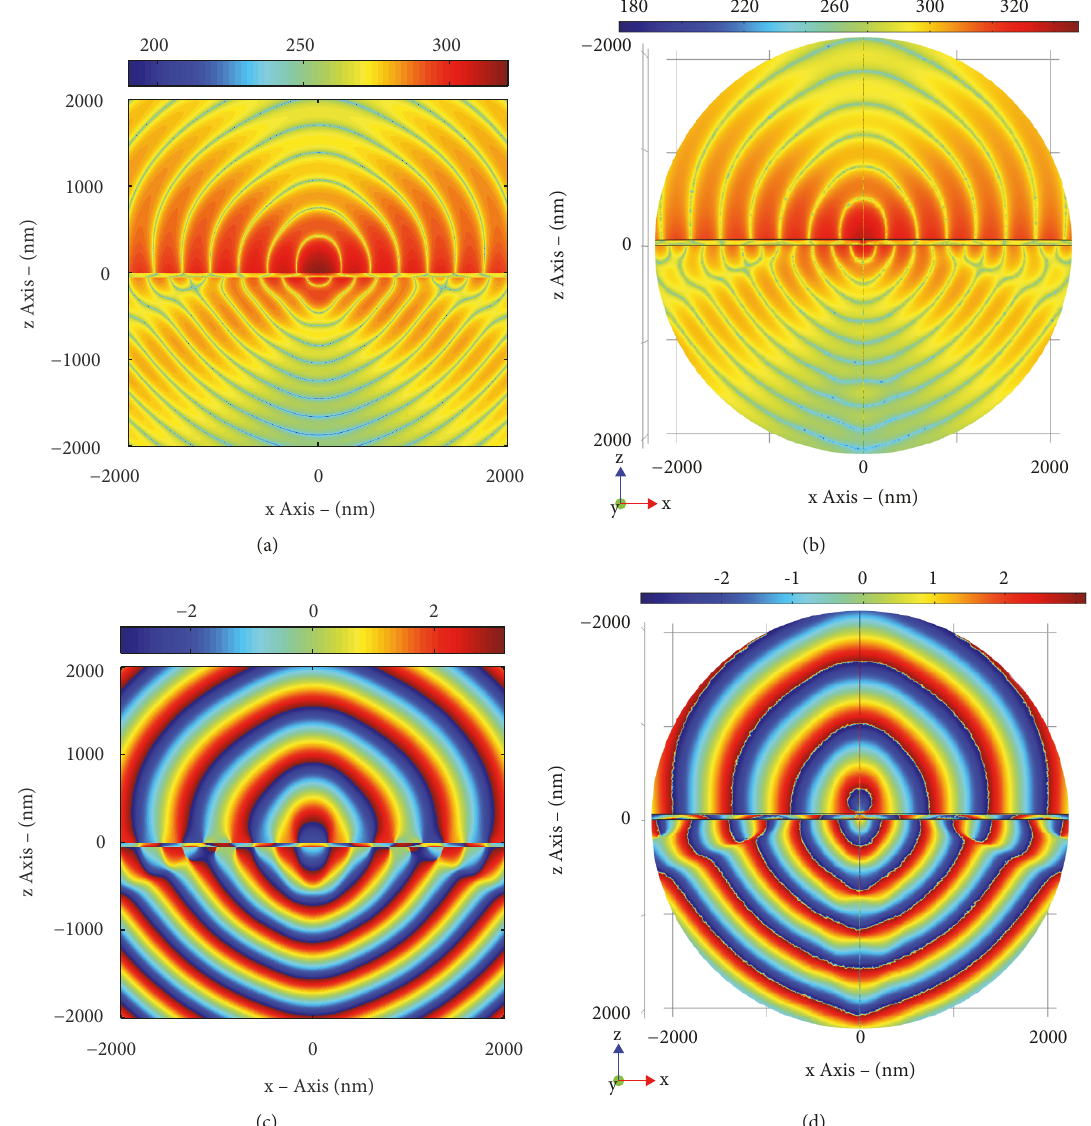
Figure 5: Component 𝐸 𝑧 , Amplitude (dB) (20 log | Re (𝐸 𝑧 )|) : (a) PGF 3D, (b) [10]; Phase (rad) (𝑎𝑛𝑔𝑙𝑒(𝐸 𝑧 )) : (c) PGF, (d) [10]. In these